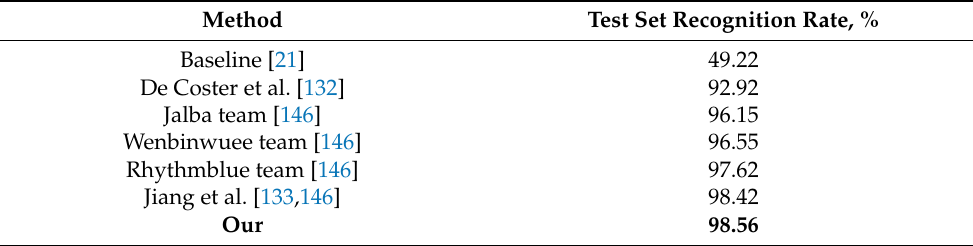
Table 12. Comparison of our method with other work (only RGB) on a test set of the AUTSL